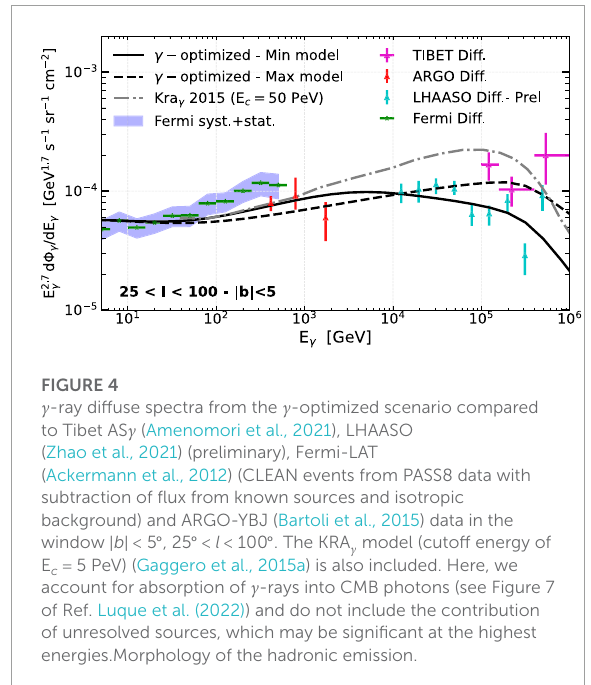
FIGURE 4 γ -ray diffuse spectra from the γ -optimized scenario compared to Tibet AS γ (Amenomori et al., 2021), LHAASO (Zhao et al., 2021) (preliminary), Fermi-LAT (Ackermann et al., 2012) (CLEAN events from PASS8 data with subtraction of flux from known sources and isotropic background) and ARGO-YBJ (Bartoli et al., 2015) data in the window | b | < 5 ° , 25 ° < l < 100 ° . The KRA γ model (cutoff energy of E c = 5 PeV) (Gaggero et al., 2015a) is also included. Here, we account for absorption of γ -rays into CMB photons (see Figure 7 of Ref. Luque et al. (2022)) and do not include the contribution of unresolved sources, which may be significant at the